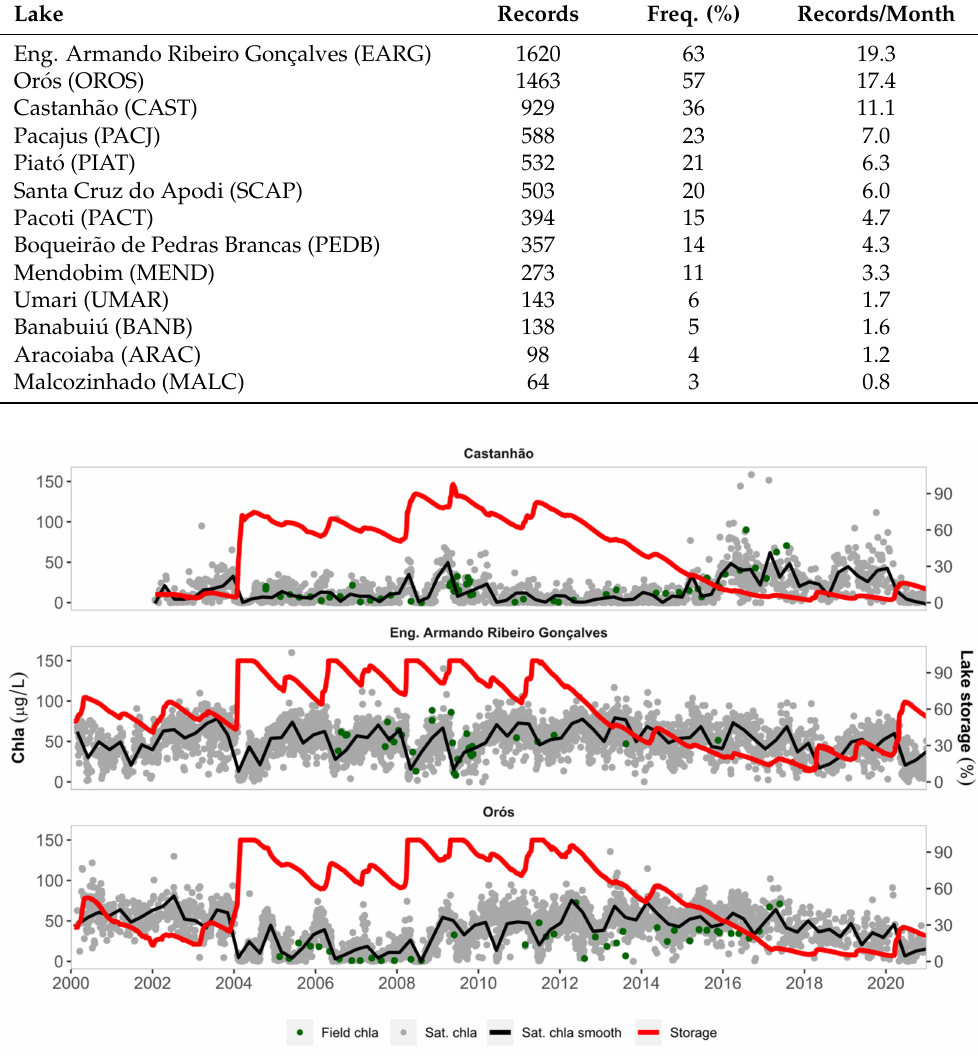
Table 5. Comparison of the frequency of daily estimated chlorophyll- a data that were successfully re- trieved from MODIS images. The period of comparison (1 January 2005–31 December 2011, 2555 days) was chosen to avoid periods when some man-made lakes were dry or still under construction.